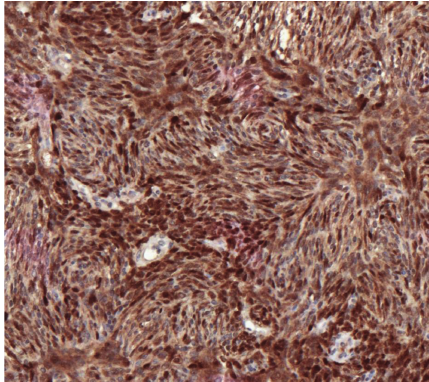
Figure 4: Immunohistochemistry—di ff use expression of calre- tinin.